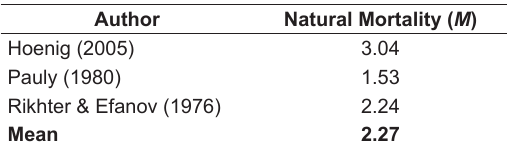
Figure 7. Age structure for the P. managuensis population at the Saco I dam, Serra Talhada-PE. White and black col- umns represent young and adult individuals, respectively. Table 1. Natural mortality rates (M) for P. managuensis , at the Saco I dam, Serra